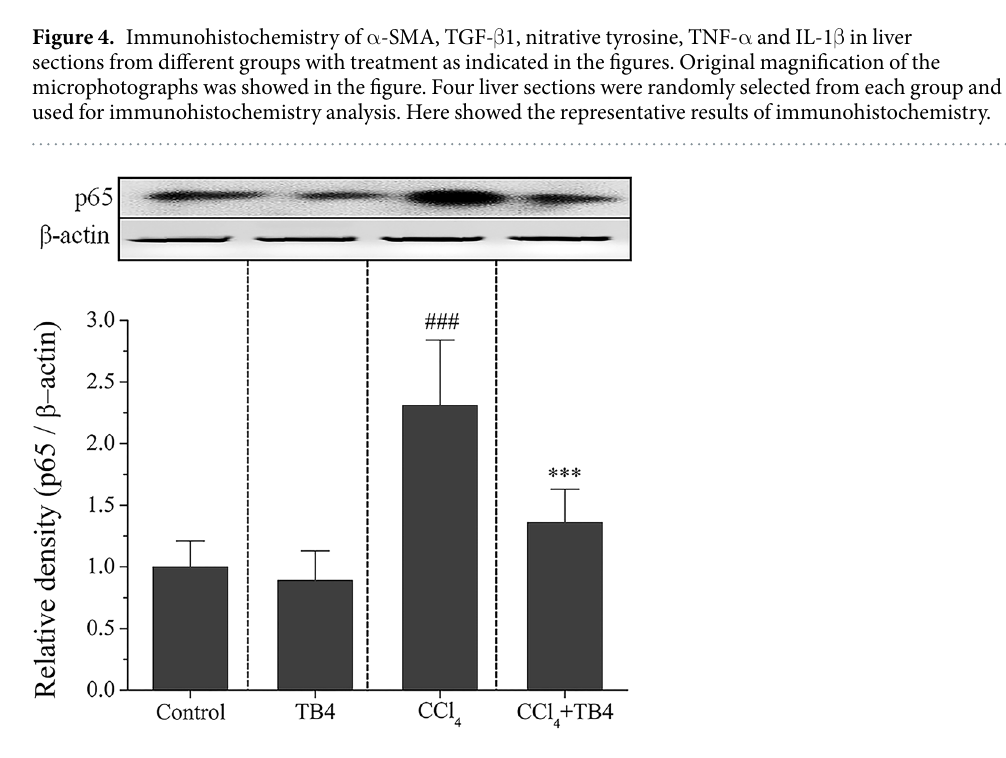
Figure 5. Western blot analysis of nuclear factor- κ B (NF- κ B) p65 protein in response to CCl 4 and thymosin β 4 (TB4) treatments. Six mice liver samples per group were analyzed by Western blot assays. Here showed the representative Western blot results and the semi-quantification results from Image J analysis. Data were expressed as mean ± standard error (n = 6). ### P < 0.01 vs. both control group and TB4 group; *** P < 0.05 vs. CCl 4 group. β -actin was used as an internal